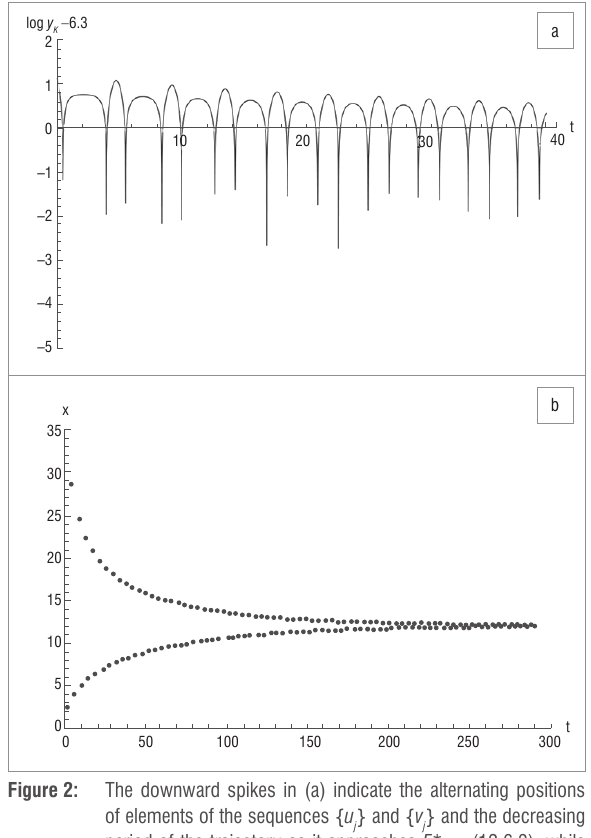
} and { v } and the decreasing j j } and j The behaviour of sequences { u } and { v } with respect to j j time ( t ). These limits of the respective sequences are only accurate to two decimals. To increase accuracy the search can be refined by decreasing the step size over smaller sub-intervals. Referring to Table 1 and using a step size of 0.000001 over the interval [287, 288] and again over [288, 289], results in Table 2, and an accuracy up to six decimals. This option allows the deduction that u* ≈ 5.389374 and v* ≈ 22.573625 are fixed points of the sequences { u } and { v }, respectively, accurate to j j six decimals, as y ( t ) → 6.600000. In Figure 5 the sequences { u } and j j { v } are shown on the xy- plane. j Again using K = 45, but now with initial value (15, 10), presumably located on the inside of the limit cycle and repeating the procedure above, generates the results in Table 3. The resulting figures of the sequences { u } → 5.389400 and { v } → 22.573552 as y ( t ) → 6.600000 are j j j shown in Figure